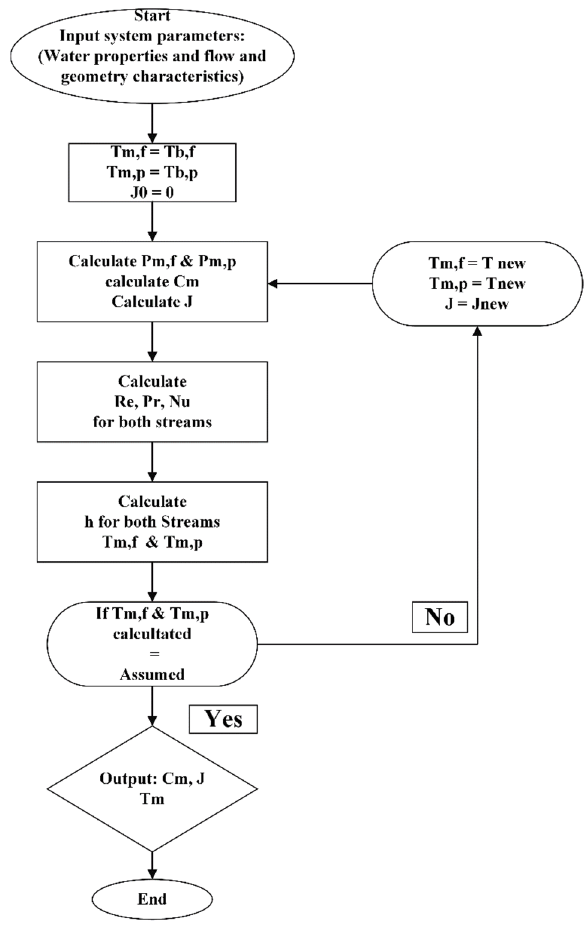
Figure A2. Here J exp and J Th are the permeate flux of experimental and theoretical results, respec- tively. Noteworthily, the experimental permeate flux was compared with theoretical results (with and without spacer) for various feed temperatures, flow rates, and concentrations in Tables A1–A3, respectively. Table A1. The error of experimental and theoretical ((A) with, and (B) without spacer) of permeate flux for different feed temperatures. Run Feed Temperature